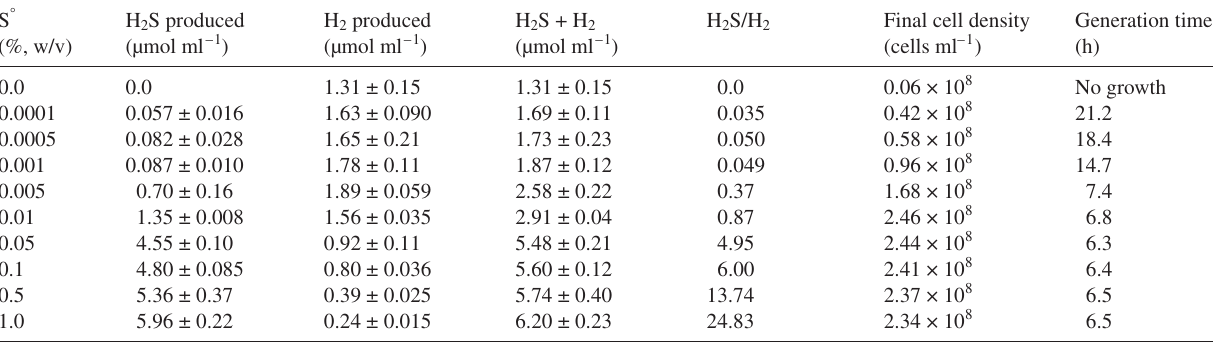
Table 1. Production of H 2 S and H 2 by S. marinus grown in the presence of different concentrations of S ° . Production of H 2 S and production of H 2 are expressed as means ± SD of two duplicate experiments. Staphylothermus marinus was grown in 25 ml of modified 0.8× SME medium for 72 h at 85 °C. For each condition, a control without inoculum was